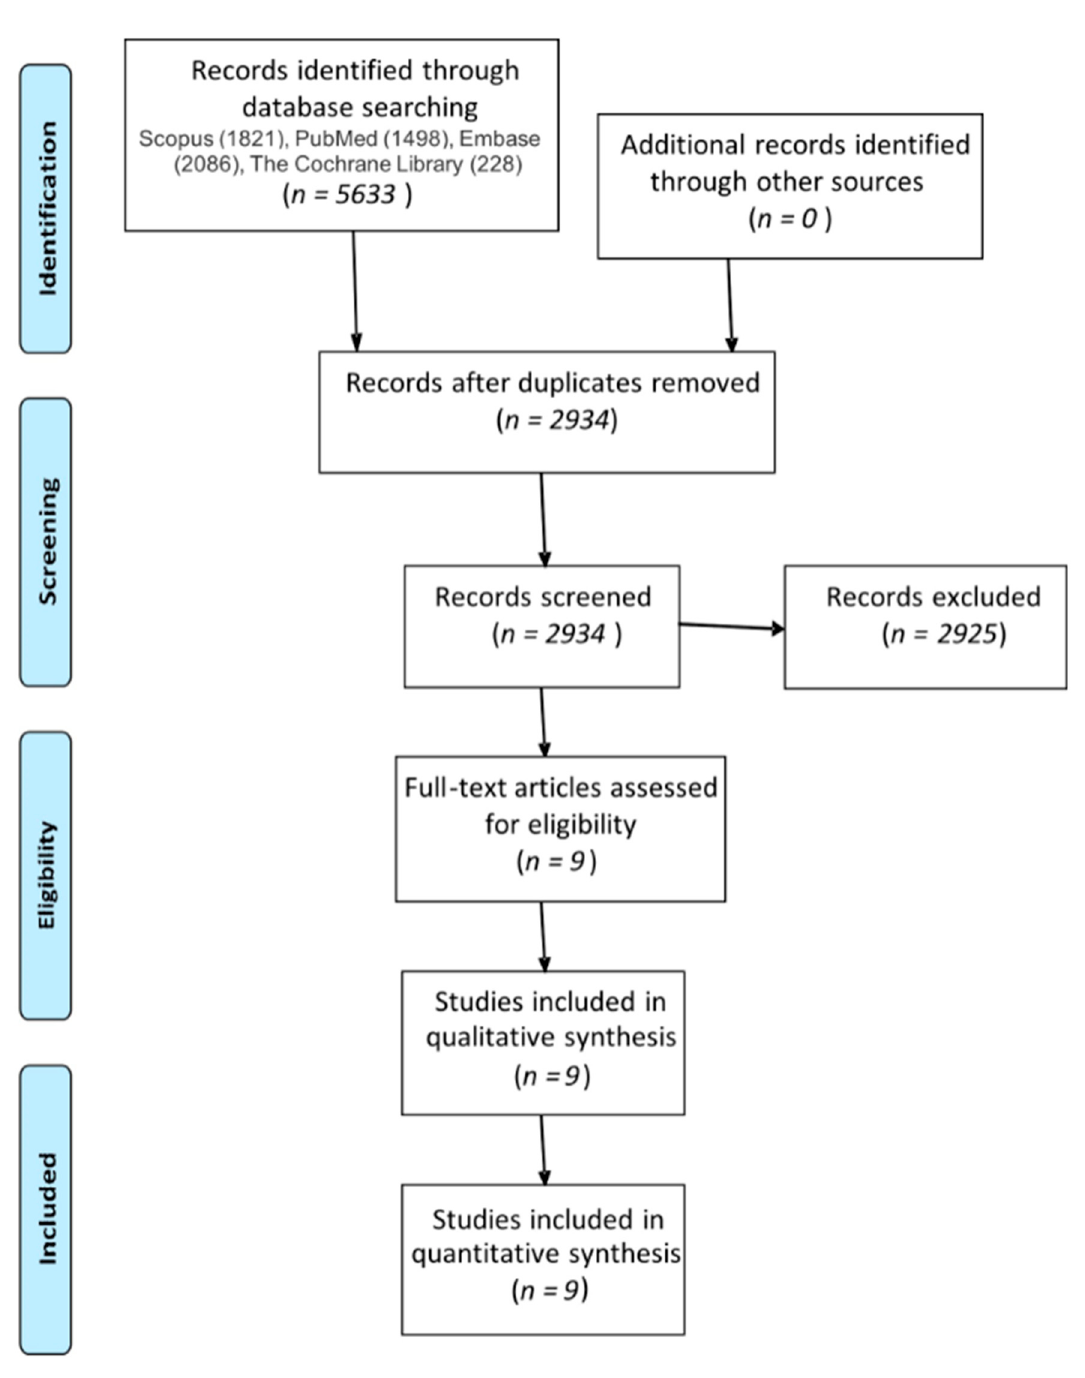
Figure 1. PRISMA flow diagram. Table 1. PICOS strategy for study characteristics.